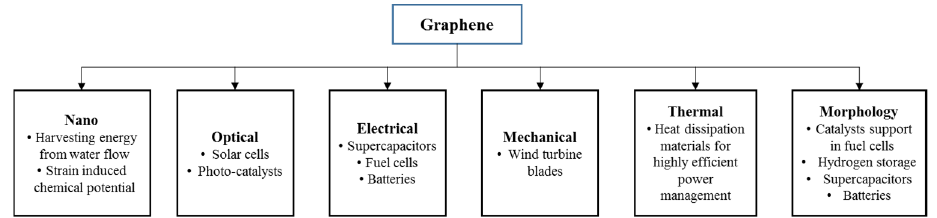
Figure 1. Correlation between graphene characteristics and their applications in energy solutions.